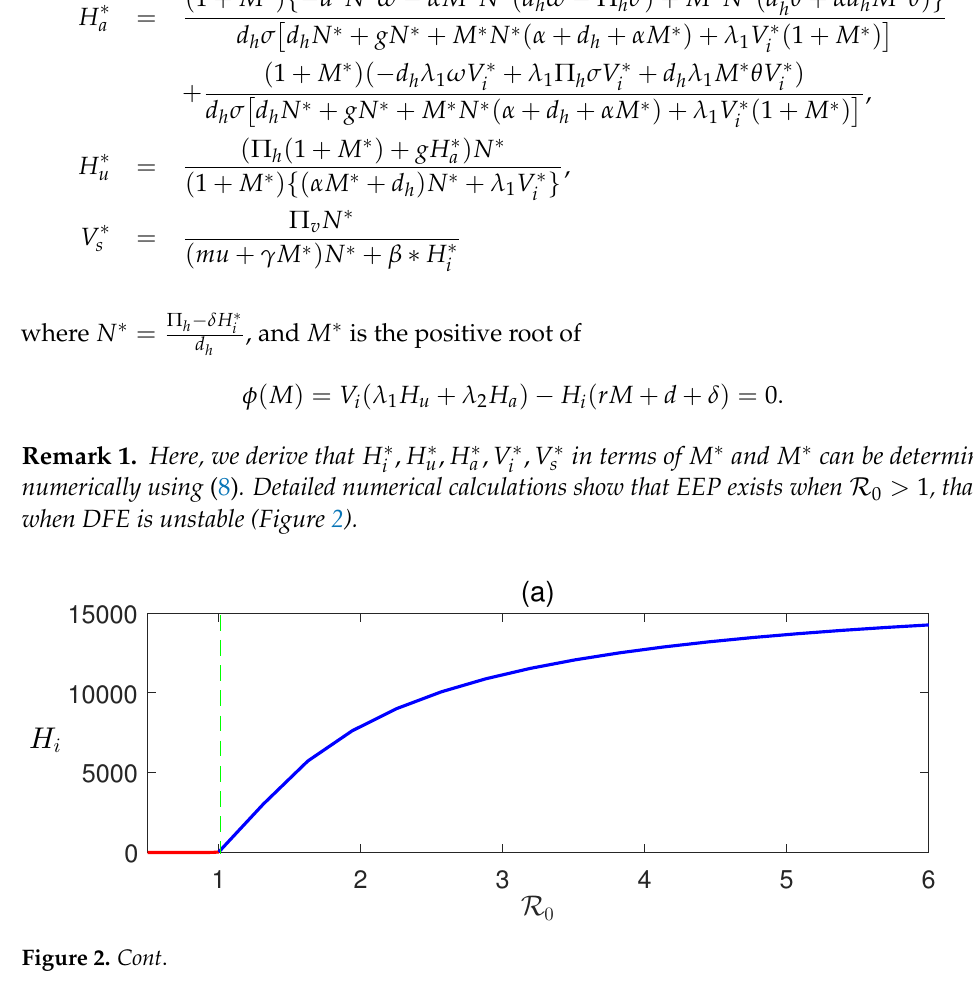
Figure 2. Forward transcritical bifurcation: equilibrium values of infected human and infective vectors are plotted with respect to the basic reproduction number R 0 . The parameter β is varied and rest of the parameters’ values are taken from Table 1. 0 (f) σ =0, ω =0 σ =0.01, ω =0.03 Figure 3. Numerical solution of the system (1) with and without the impact of awareness.